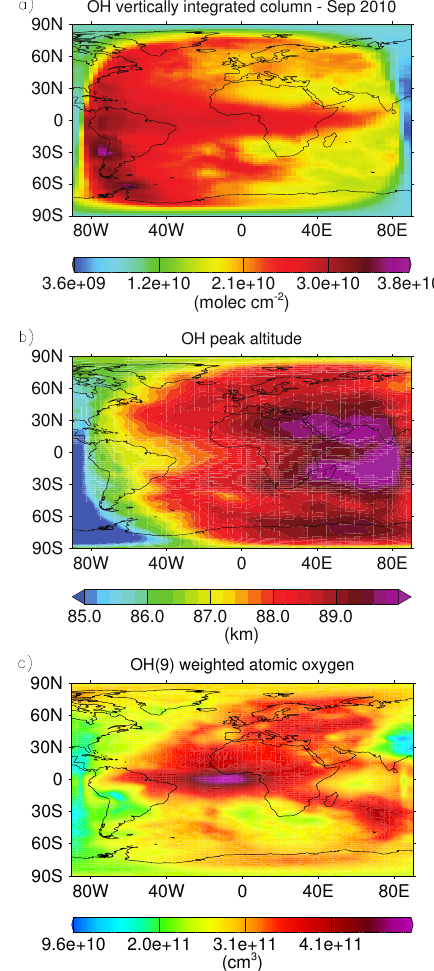
Figure 2. Monthly averaged model results around September 2010 equinox. (a) Vertically integrated number density of simulated 9 P OH (ν i ) . (b) Weighted peak altitudes of simulated OH emission i = 1 layer according to our definition D.1. (c) O concentrations weighted with vertical OH( ν = 9)